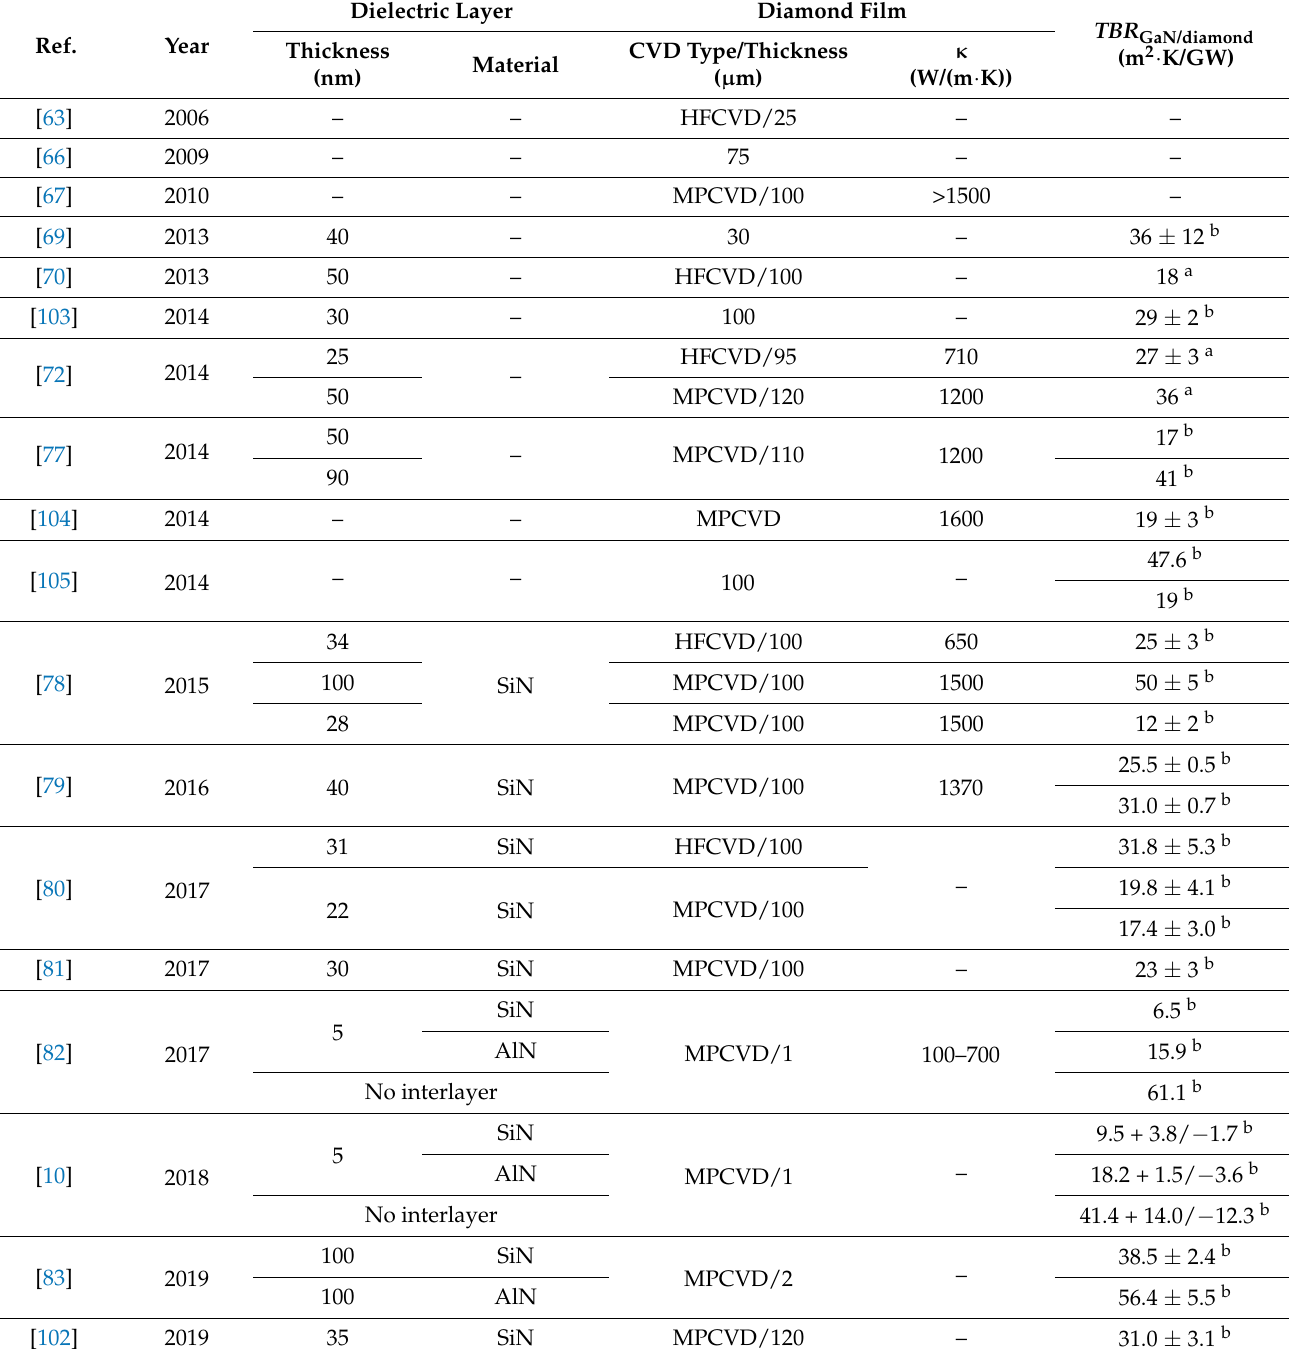
Table 3. Evolution of GaN-on-diamond